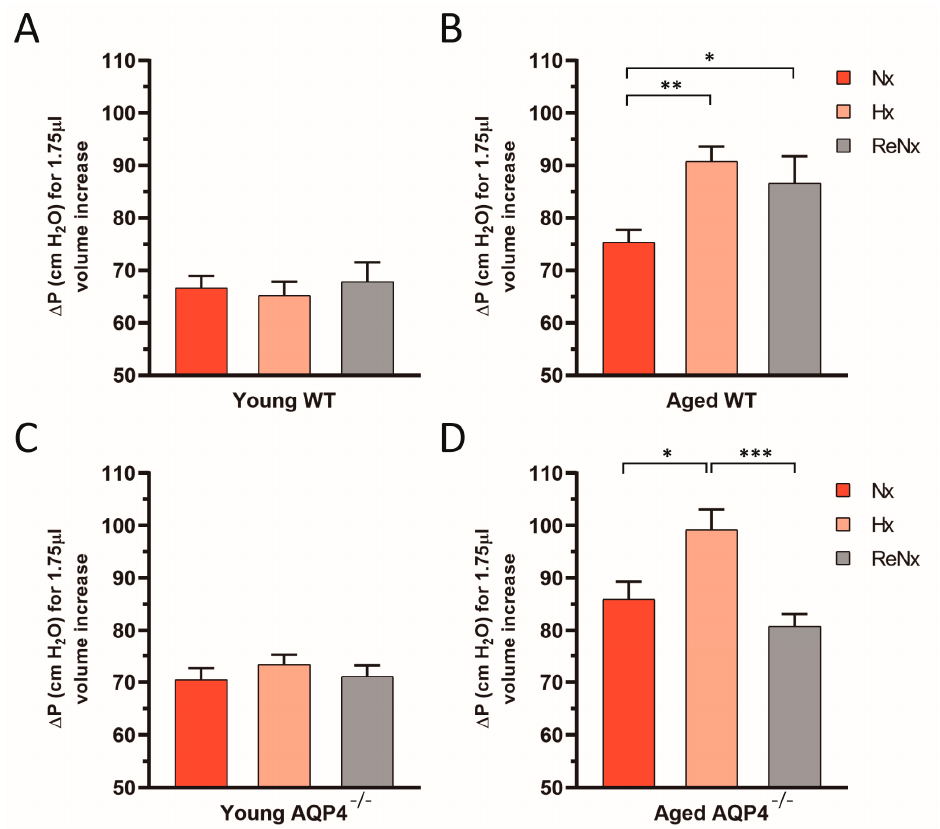
Figure 4. Alterations in the compliance of the cerebral ventricular system after re-normoxia. Quantitative analysis of the increment of IVP ( ∆ P) reached in 15 s after the infusion of 1.75 µ L of artificial CSF for each experimental group. ( A ) Young wt, ( B ) aged wt, ( C ) young AQP4 -/- , ( D ) aged AQP4 -/- . Note that ventricular compliance is inversely proportional to ∆ P, so the compliance of the ventricular system remains diminished in aged wt mice after the ReNx period but is recovered in aged AQP4 -/- animals. Data are represented as mean ± SEM. Number of animals analyzed for each experimental condition: Young-wt, Nx ( n = 12); Hx ( n = 7); ReNx ( n = 6). Aged-wt, Nx ( n = 8); Hx ( n = 7); ReNx ( n = 5). Young-AQP4 -/- , Nx ( n = 10); Hx ( n = 8); ReNx ( n = 8). Aged-AQP4 -/- , Nx ( n = 8); Hx ( n = 6); ReNx ( n = 8). * p < 0.05; ** p < 0.01; *** p < 0.001.